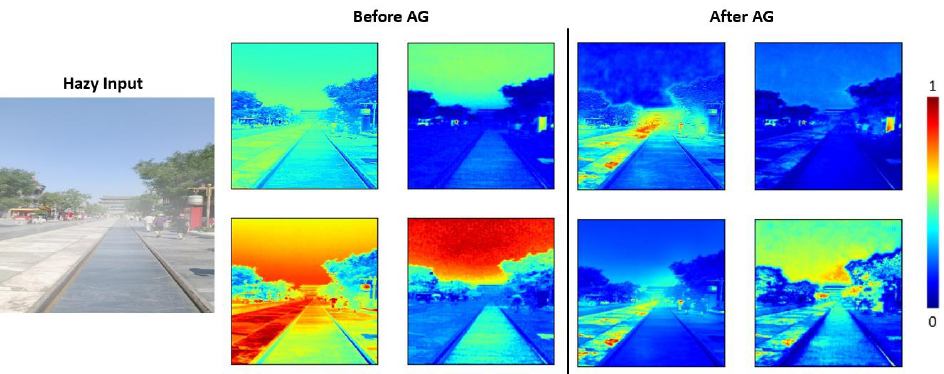
Figure 6. The effect of selecting four random feature maps before and after passing through AG 1.